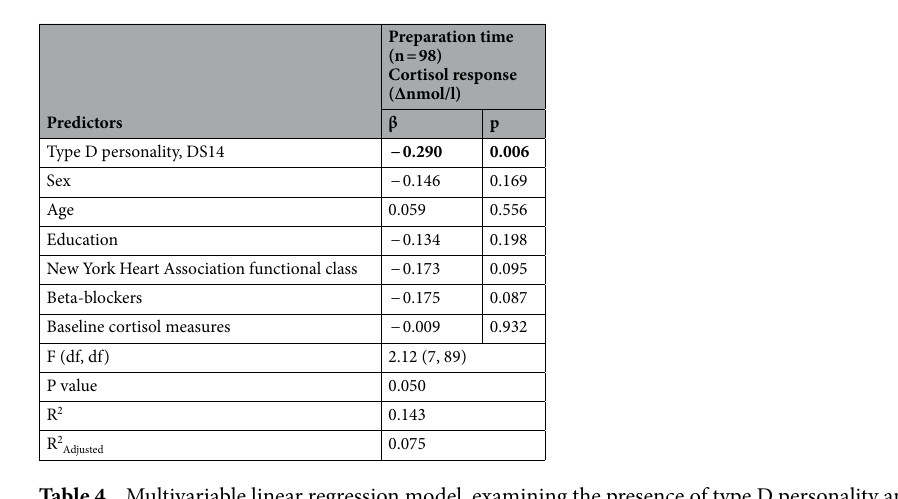
Table 4. Multivariable linear regression model, examining the presence of type D personality and its links with cortisol response to Trier Social Stress Test, while controlling for possible confounds. *Significant correlations ( p value < .05) in bold. DS14, Type D